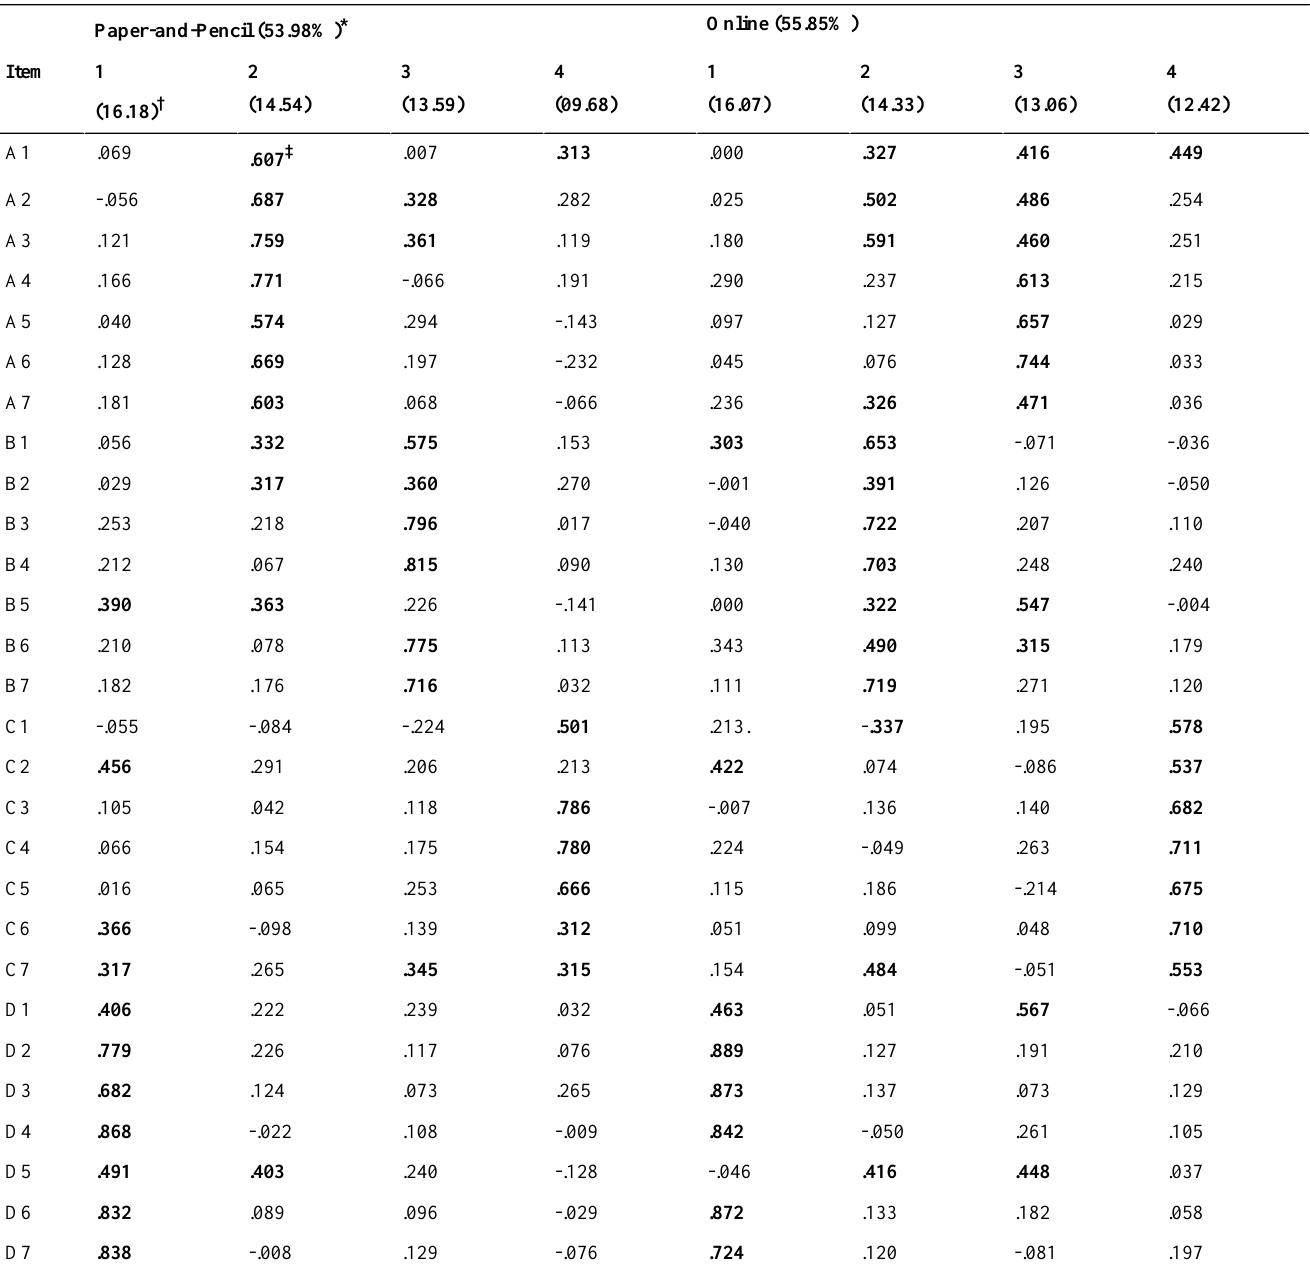
Table 3. GHQ-28 item factorial loads (varimax rotation): A: somatization, B: anxiety; C: social dysfunction; D: depression